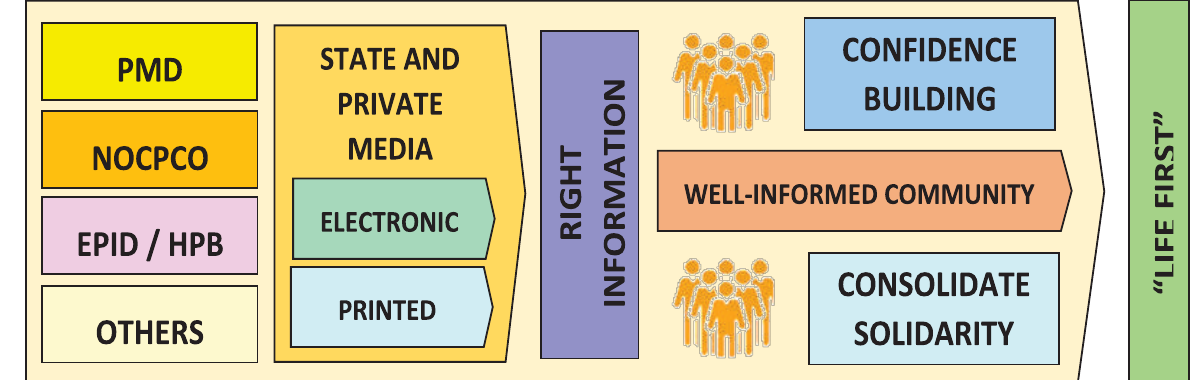
Figure 4: Conceptualization of the Psychological